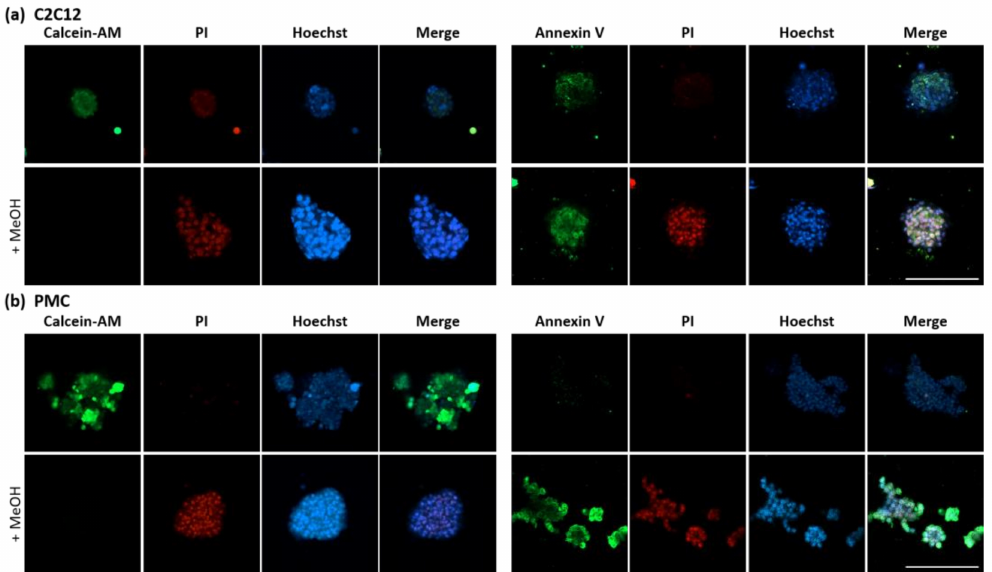
Figure 4. Cell viability in the myospheres. After 7 days of cultivation, spheroids of C2C12 ( a ) and PMCs ( b ) were directly stained and observed by confocal microscopy. Live or apoptotic cells were stained by Calcein-AM and Annexin V, respectively; dead cells were stained by PI. In control spheroids, apoptosis and cell death were induced by treatment with methanol. All spheroids were viable without signs of cell death. The C2C12 spheroids showed minor indications of apoptosis, which were not seen in PMCs. Scale bar: 200 µ